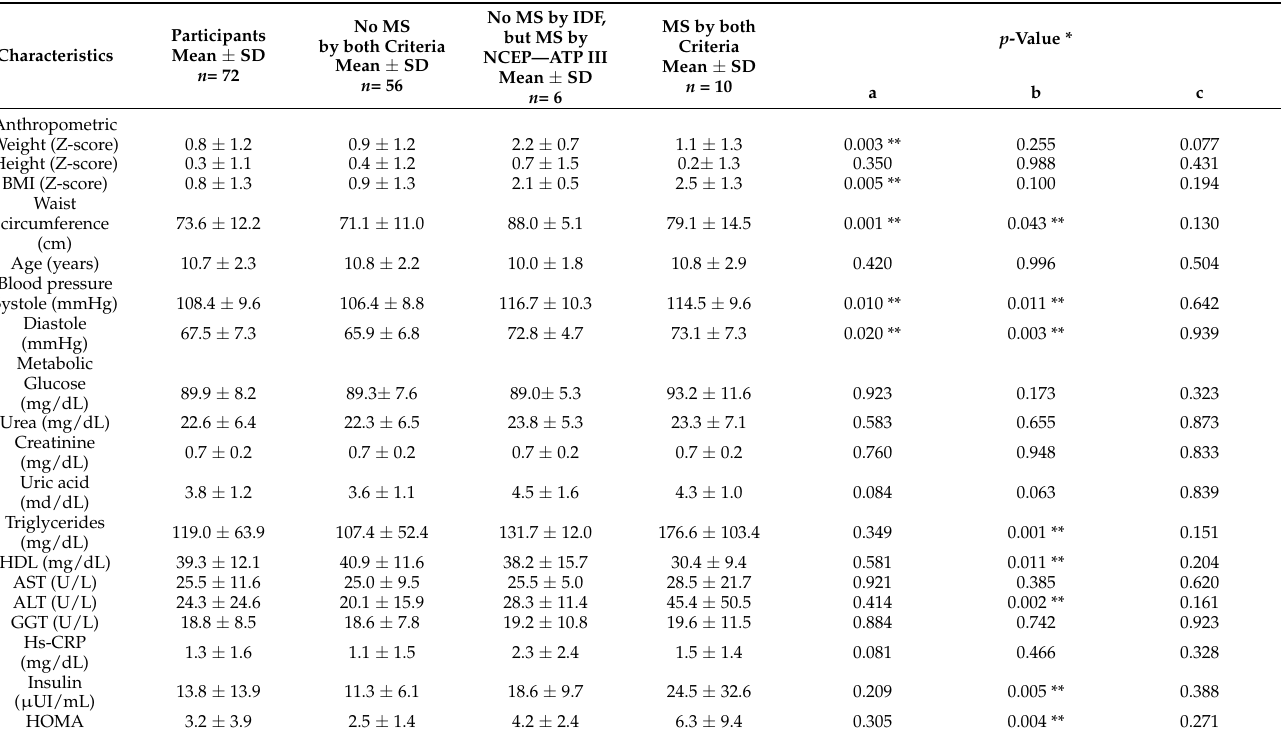
Table 2. Anthropometric characteristics and biomarkers of children and adolescents in Huatusco, Veracruz,